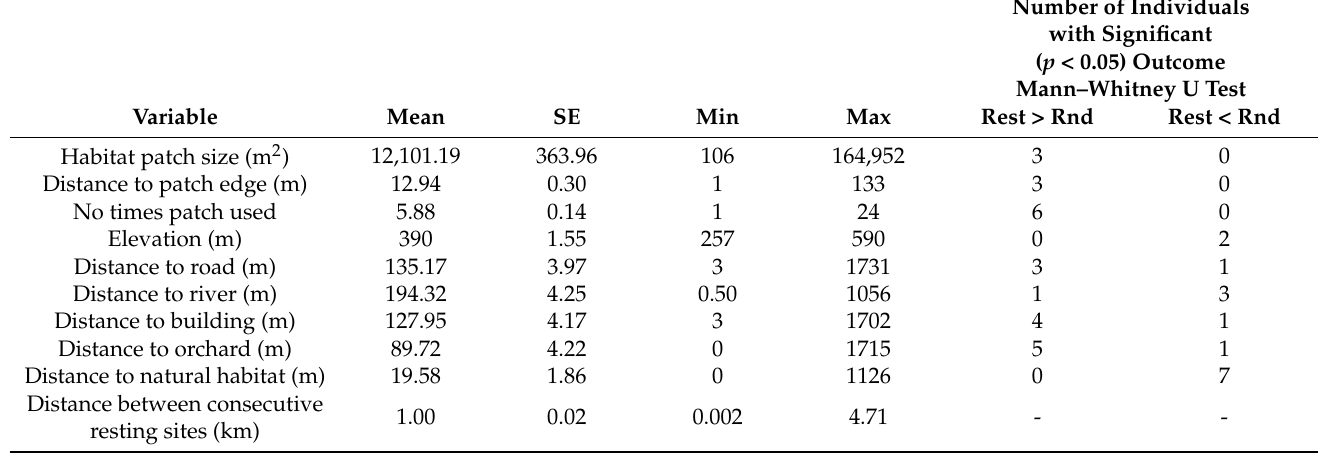
Table 3. Description of leopard cat daytime resting site characteristics: habitat patch size, distance to patch edge, number of times used, elevation and nearest distance to roads, rivers, buildings, and orchards for leopard cat resting sites, plus an overview of the significant outcomes of the Mann–Whitney U tests for differences between resting sites (Rest) and random points (Rnd) for the individual leopard cats.